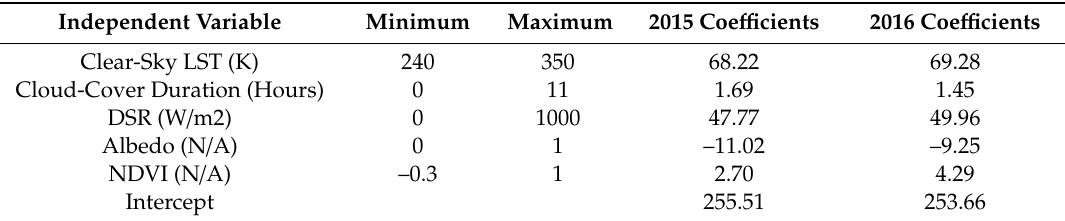
Table 3. Maximum and minimum values used for normalization and multiple linear regression coe ffi cients in 2015 and